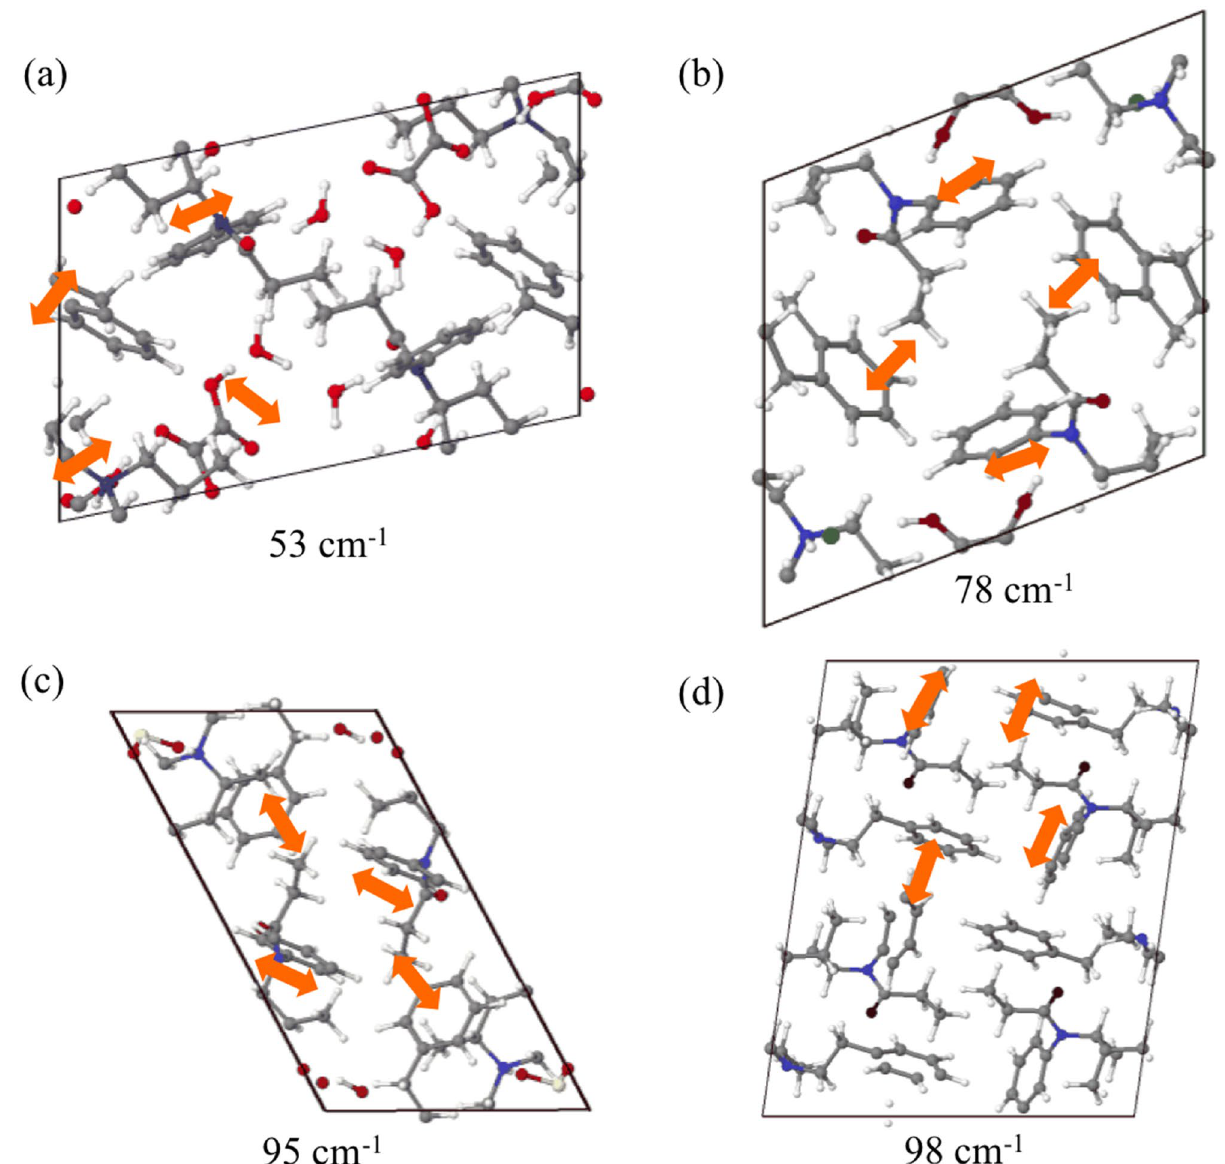
Figure 6. Normal modes of ( a ) FOPFIZ in 53 cm −1 along with a-axis, ( b ) CEWDEN10 in 78 cm −1 along with a-axis, ( c ) JINPAX in 95 cm −1 along with c-axis, and ( d ) VEYCIL in 98 cm −1 along with b-axis. Strongest peaks in THz range are shown. Carbon, hydrogen, nitrogen, and oxygen atoms are depicted as grey, white, blue, and red spheres,